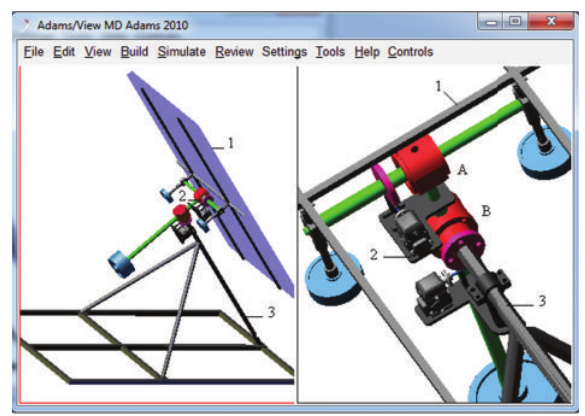
Figure 2: The MBS model of the equatorial tracking